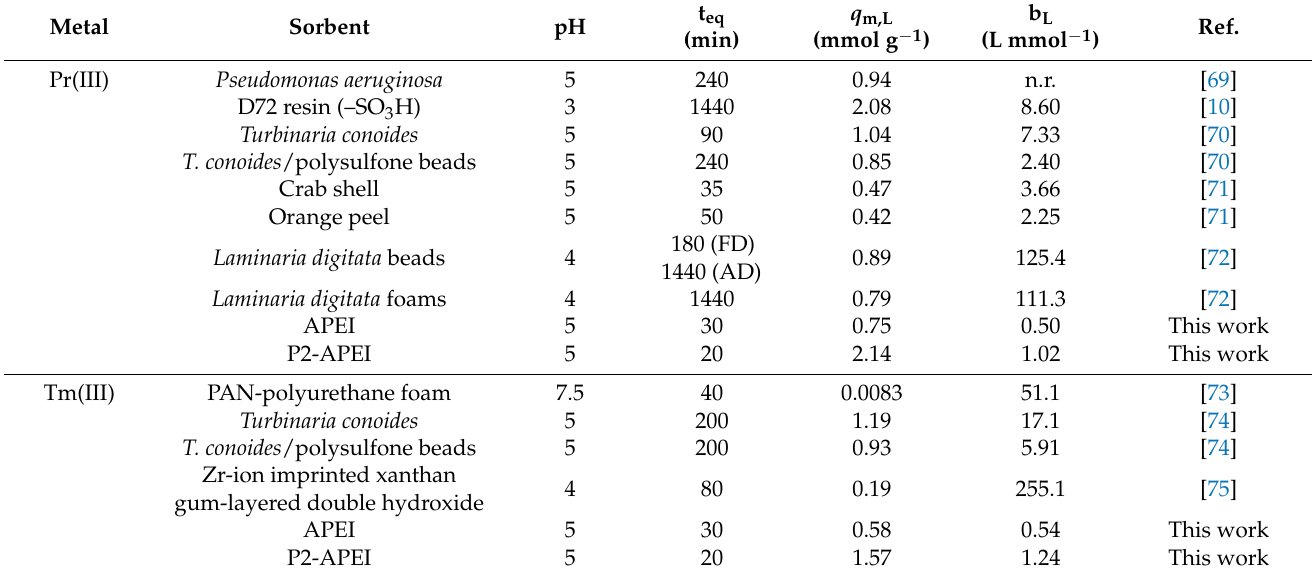
Table 5. Comparison of the Pr(III) and Tm(III) sorption properties for alternative